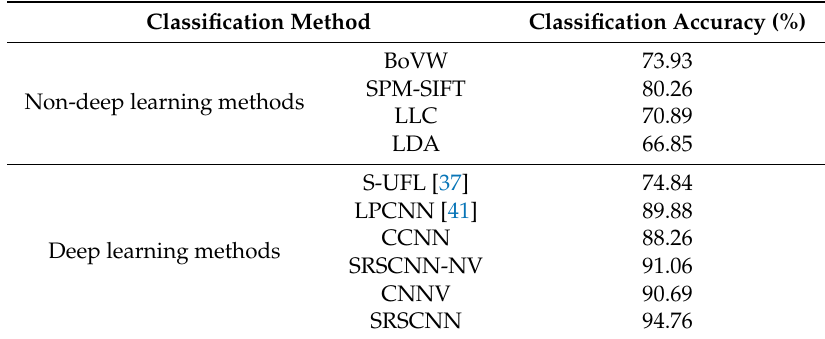
Table 3. Comparison between the previous reported accuracies with the Google dataset of SIRI-WHU, with 80% training samples selected.